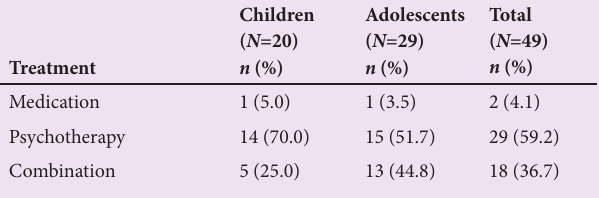
Table 6. Treatment of children and adolescents with